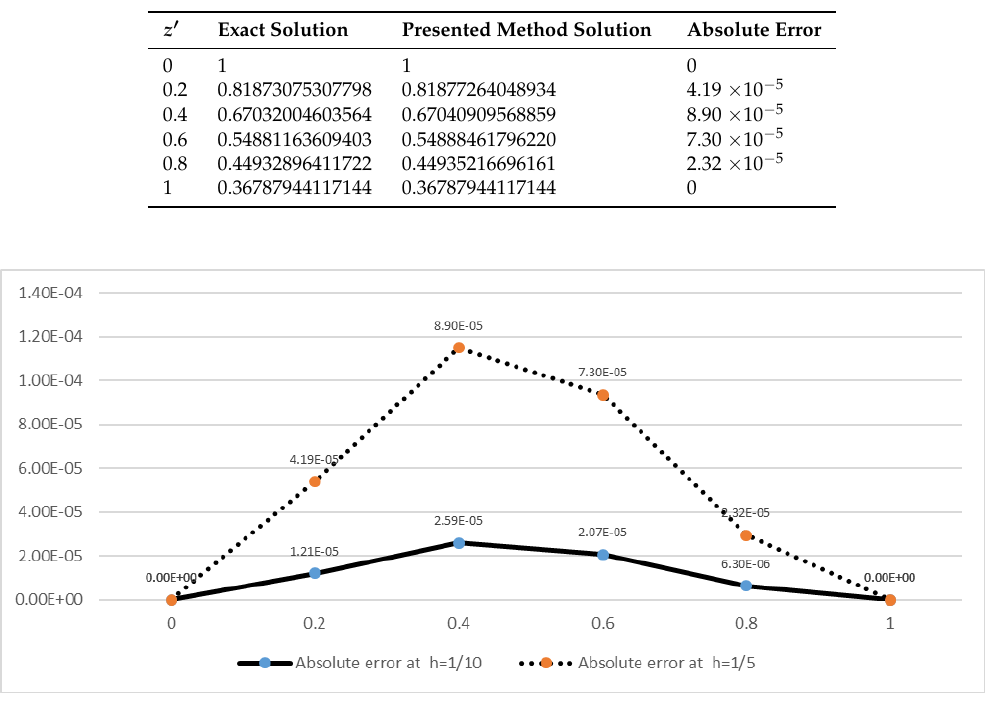
Figure 6. Graphical comparison of Problem 6 at h = 1